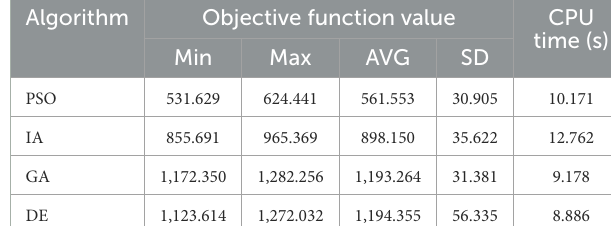
TABLE 5 Comparison of the results solved by different algorithms.